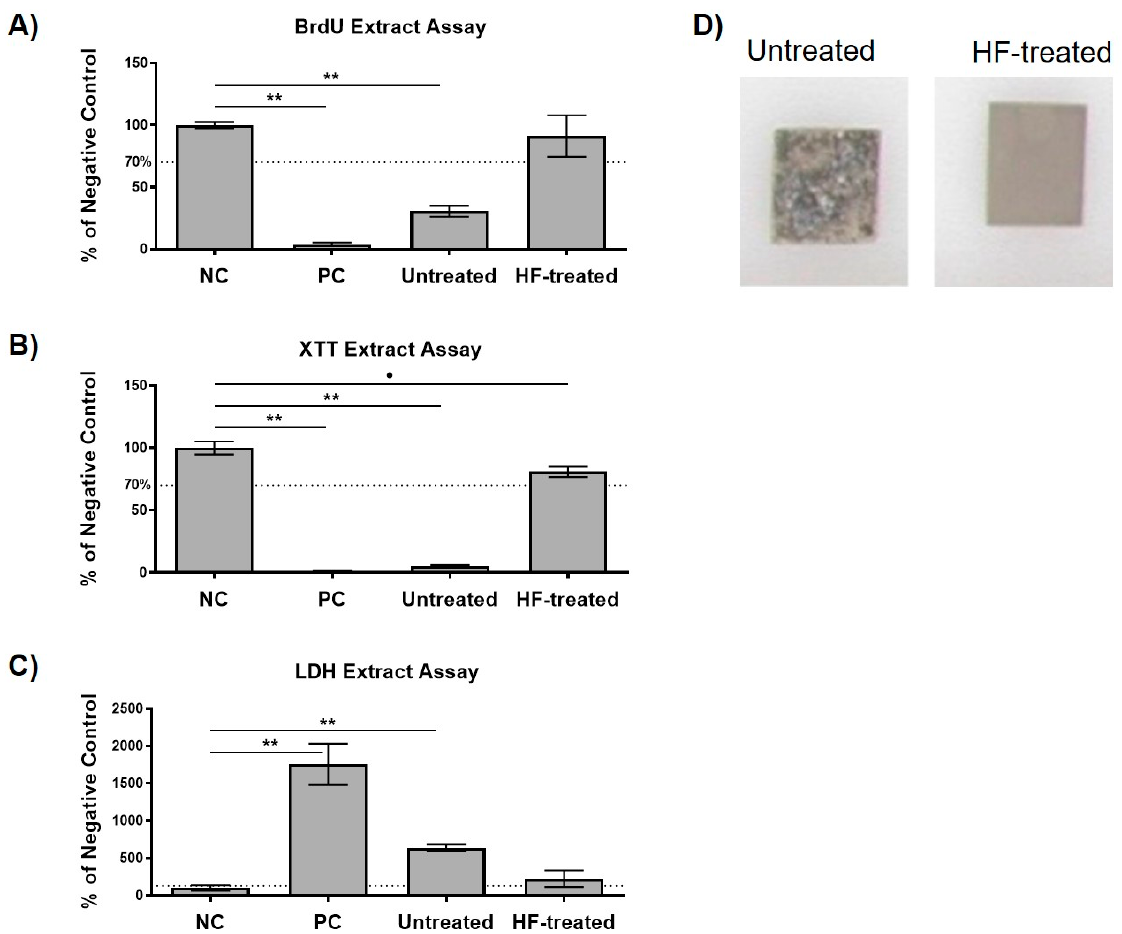
Figure 4. Cytocompatibility results using L9292 cells of the different variants. ( A ) proliferation measured by a BrdU assay; ( B ) viability measured by a Sodium 3,3 ′ -[1(phenylamino)carbonyl]-3,4-tetrazolium]-3is(4-methoxy-6-nitro) Benzene Sulfonic acid Hydrate (XTT)-assay; ( C ) cytotoxicity measured by a Lactate Dehydrogenase (LDH) assay. Values are either normalized against positive controls (LDH) or negative control (XTT, BrdU). Means with error bars indicating standard deviations. The dotted line indicates thresholds which should not be exceeded (LDH) or fall below (XTT; BrdU). Significant differences are indicated ( • : p < 0.05, **: p < 0.01). ( D ) Both untreated and HF-treated magnesium after 72 h extraction. The untreated magnesium shows enhanced corrosions, which is visible due to the high surface porosity and black textured corrosion products. The HF-treated magnesium was not different from the initial morphology.